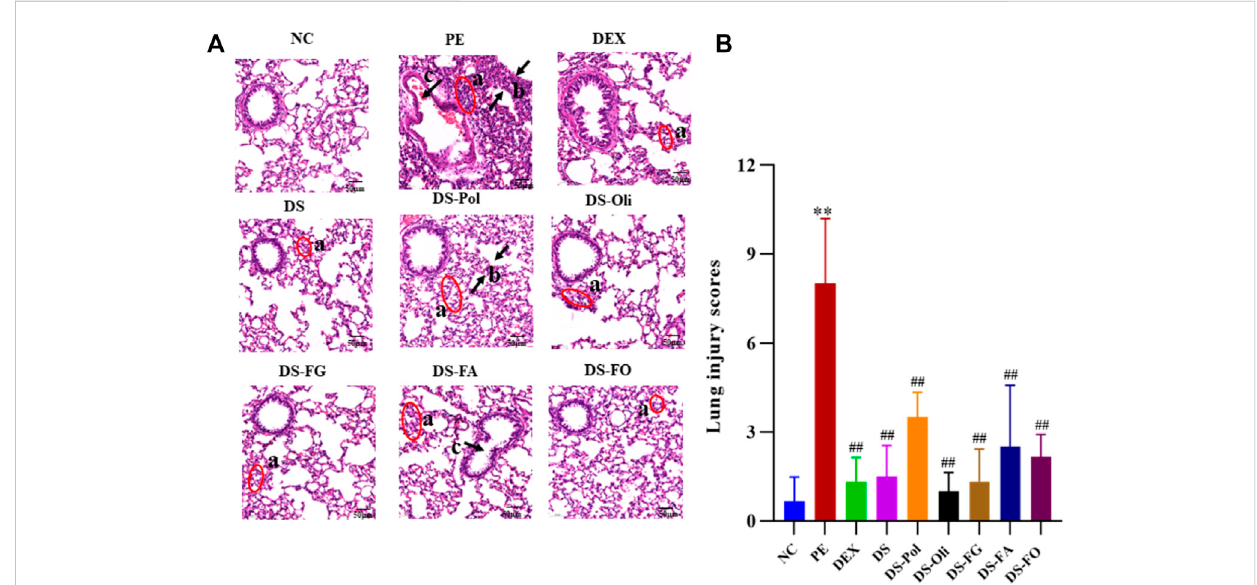
FIGURE 1 Effects of DS and its fi ve fractions on lung histopathological change of PE model (A) . And their semiquantitative score of lung edema severity (B) . All data were expressed as mean ± SD, n = 3, ** p < 0.01, vs. NC; ## p < 0.01, vs. PE. The above lung sections chosen randomly from three left lung lobes sampleofeachgroup,respectively,werestainedwithhematoxylinandeosin(H&E,×200).a,in fi ltrationofin fl ammation;b,thickeningofthealveolarwall; c, narrowing of airway